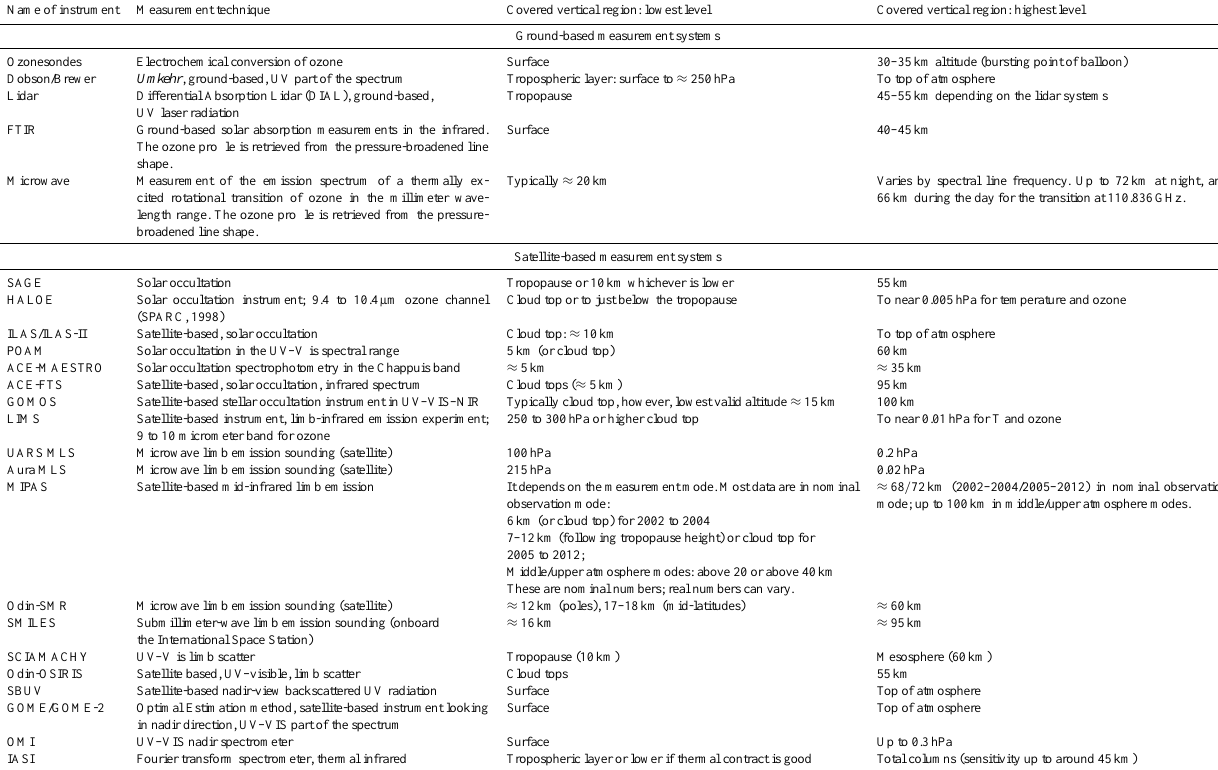
Table 1a. Summary of measurement techniques and lowest and highest covered level for the five ground-based measurement systems and all described satellite measurement